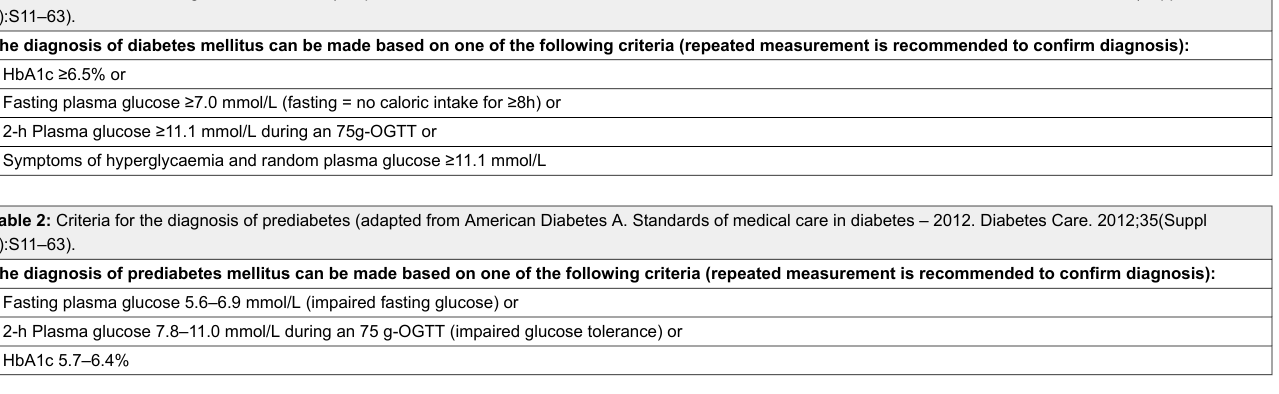
Table 3: Criteria for testing asymptomatic individuals for diabetes (adapted from American Diabetes A. Standards of medical care in diabetes – 2012. Diabetes Care. 2012;35(Suppl 1):S11–63). Asymptomatic adult individuals should be tested for diabetes